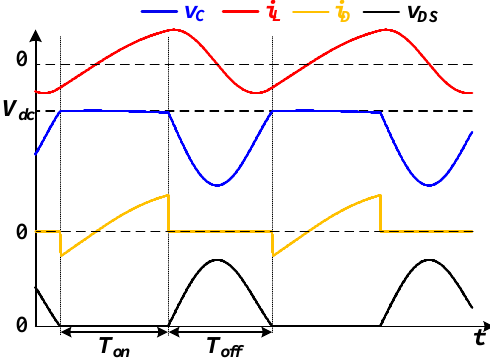
Figure 2. Idealized current and voltage